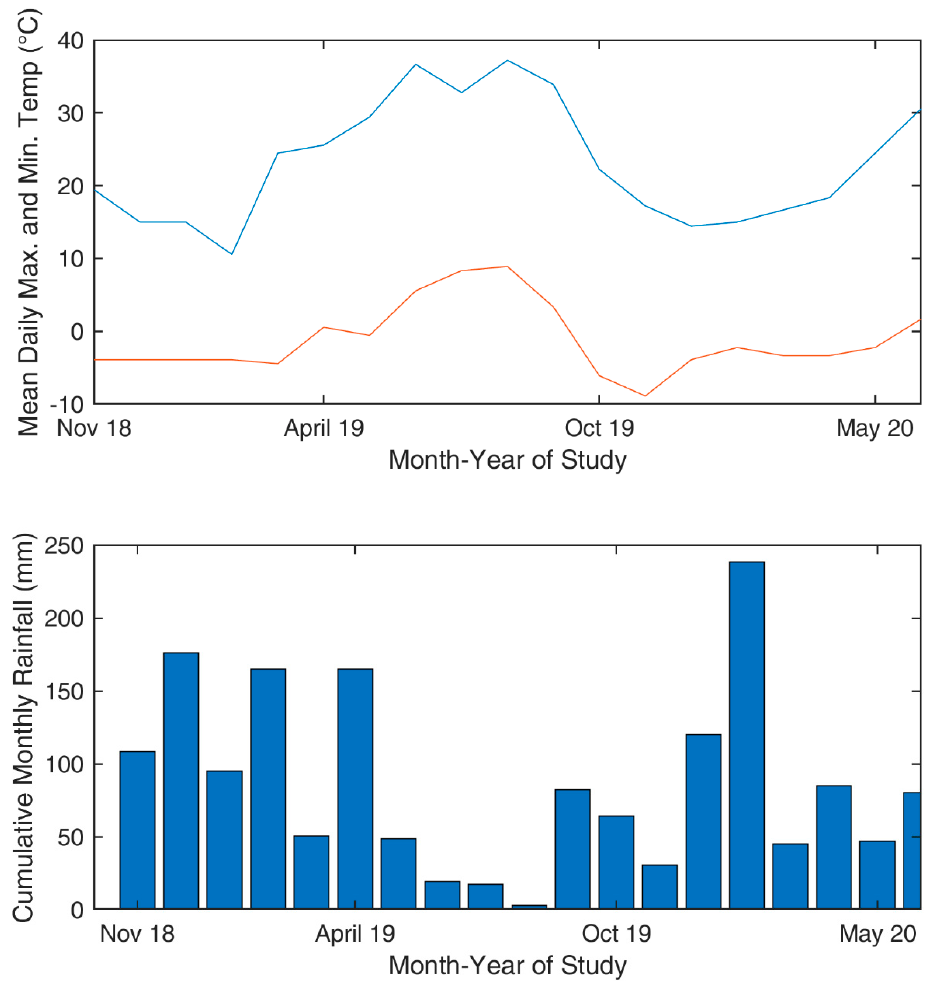
Figure 2. Maximum and minimum temperature and monthly rainfall for the Oregon State University Hyslop Farm during the study.